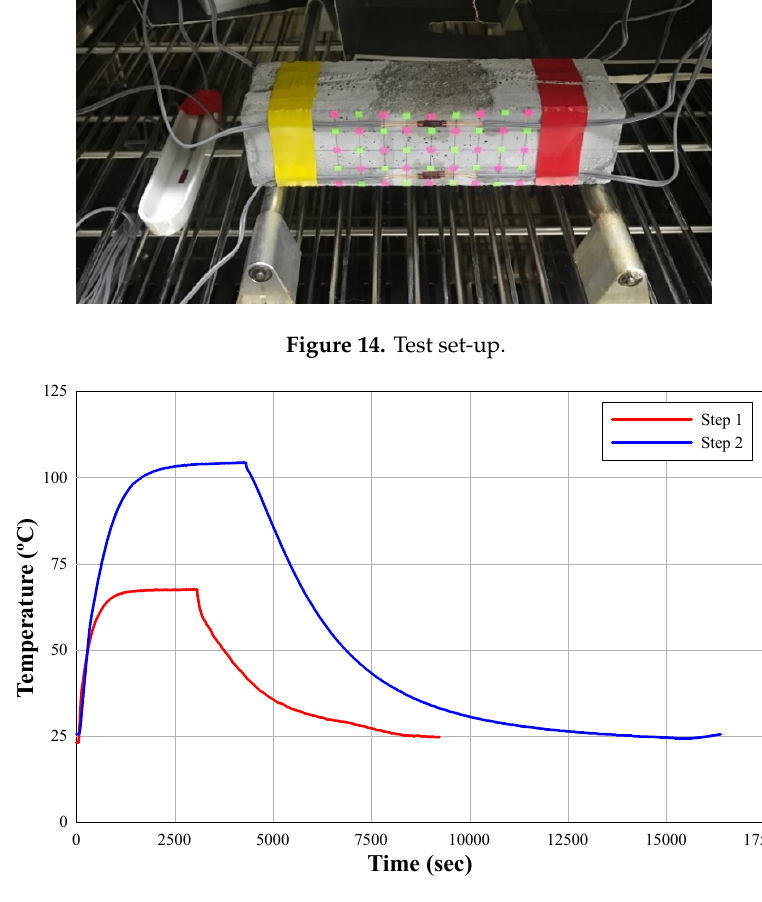
Figure 15. Chamber temperature variation.